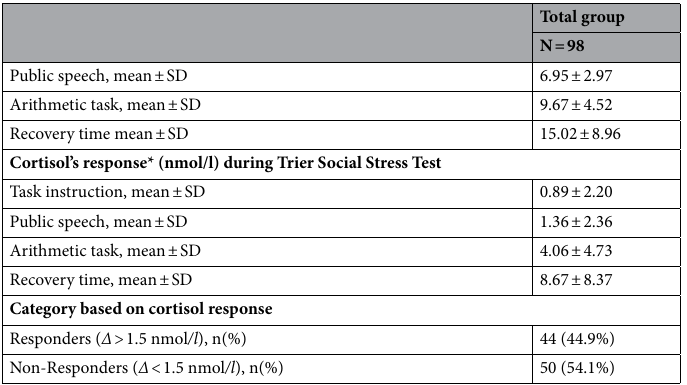
Table 1. Descriptive information of study participants. *The value of cortisol response (Δnmol/l) was derived by subtracting the cortisol value during Baseline rest from the cortisol value during the specific Trier Social Stress Test phase.